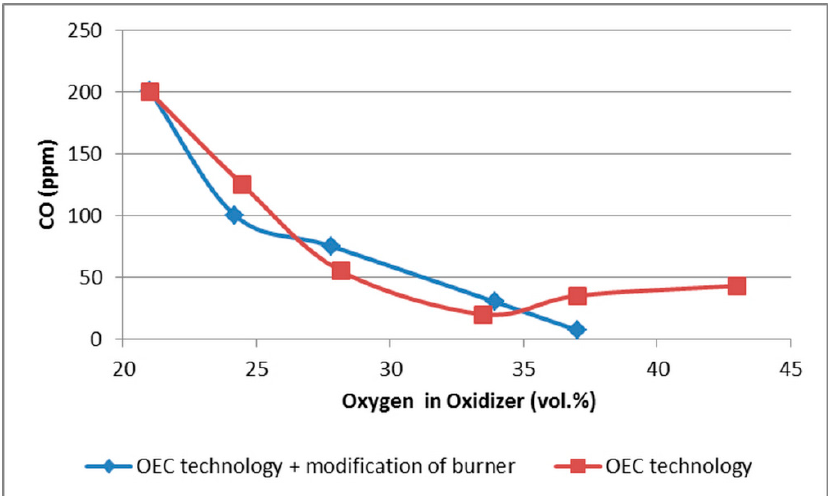
Figure 8. Dependence of CO concentration in flue gas on concentration of oxygen in oxidizer (experimental measurements).